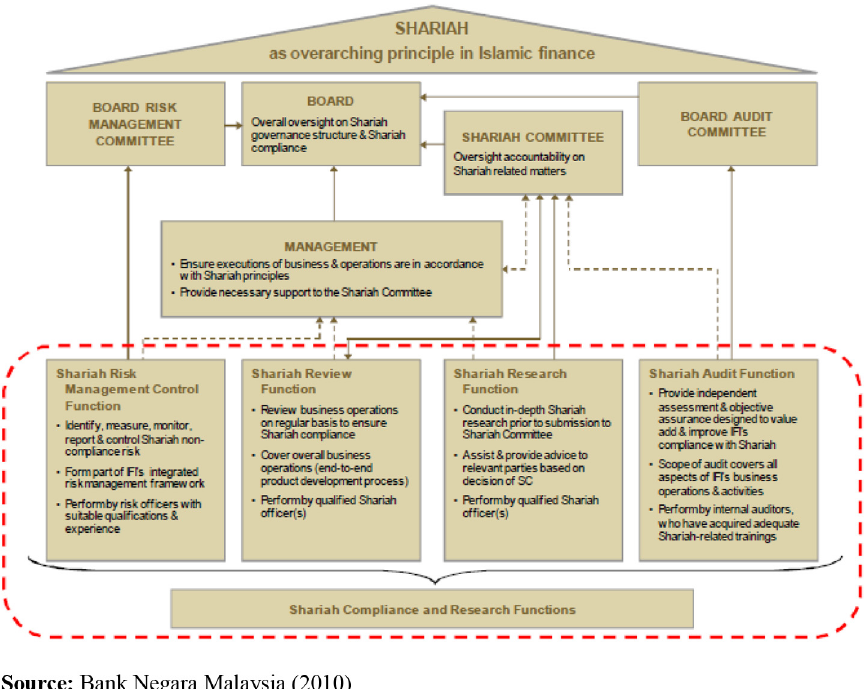
Figure 1. Key organs in an IFI ’ s Shar ī ʿ ah governance